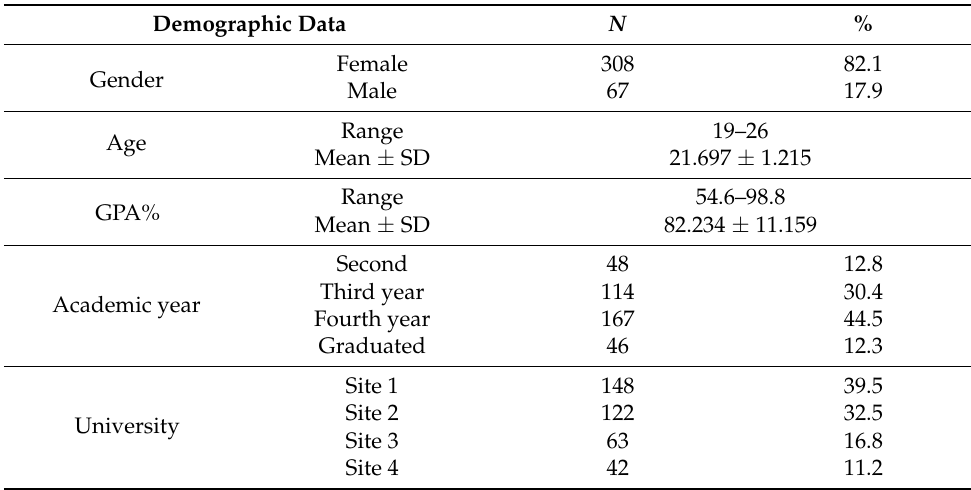
Table 1. The frequency and percentage regarding demographic data (Gender, Age, GPA, Academic year, University) in study group ( n =